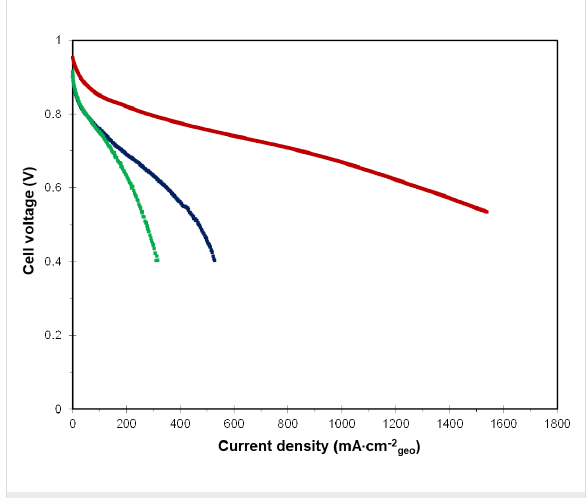
Figure 11: Polarization of Pt 3 Co/CB (red), unwashed Pt 3 Co/N-CNT (dark blue) and unwashed Pt 3 Ni/N-CNT HT (green) recorded under air, P inlet = 2.5 bar, T = 80 °C, St H2 = 1.2; St Air = 3.5, RH anode = 50%; RH cathode = 30%.